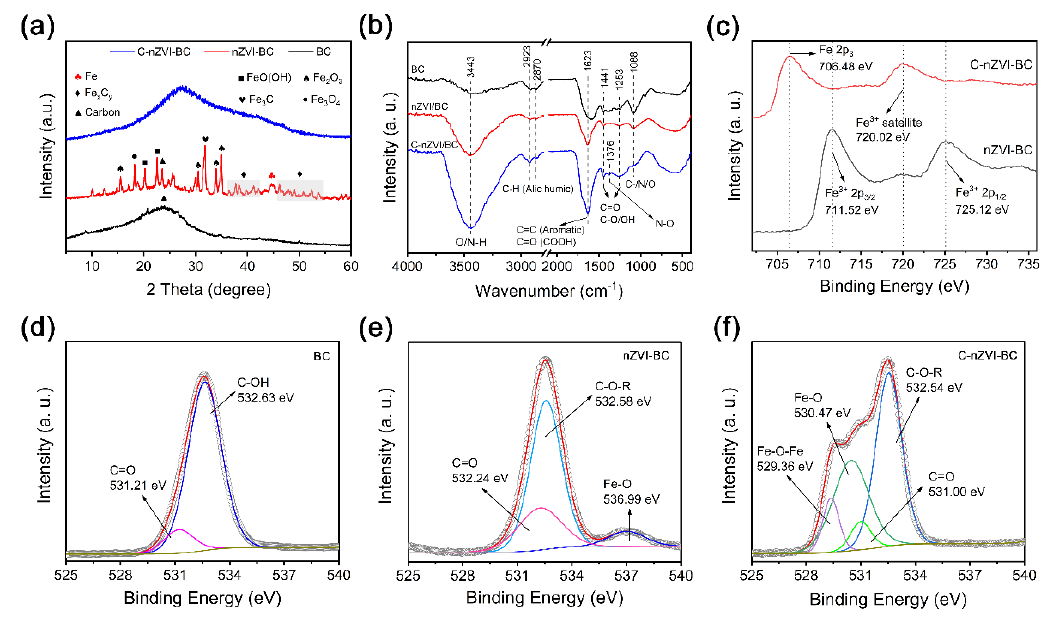
Figure 2. Characterization of BC, nZVI–BC, and C–nZVI–BC. Powder X-ray diffraction (PXRD) patterns ( a ); FTIR spectra ( b ); high-resolution X-ray photoelectron spectroscopy (XPS) spectra of Fe